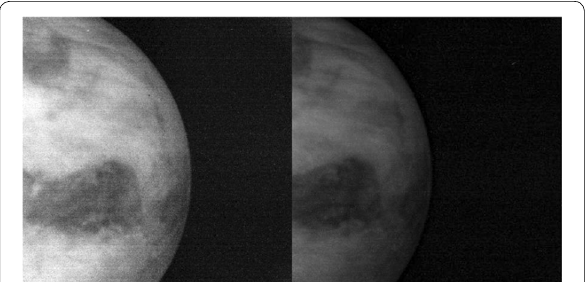
Fig. 18 (left): A 0.90‑μm nightside Level 2 image at 00:44 on January 21, 2016, at a distance of 43,000 km with a sub‑spacecraft latitude of 3°, a longitude of 66° and a phase angle of 146°; (right): A 0.97‑μm + nightside Level 2 image at 00:37 on Jan. 21 2016, at a distance of 44,000 km with a sub‑spacecraft latitude of and a phase angle of